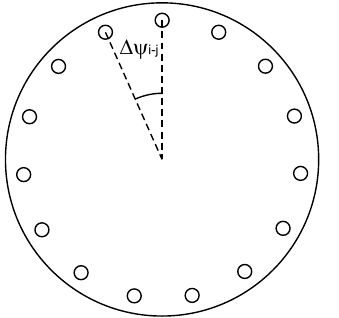
Figure 7. Encoder disk.